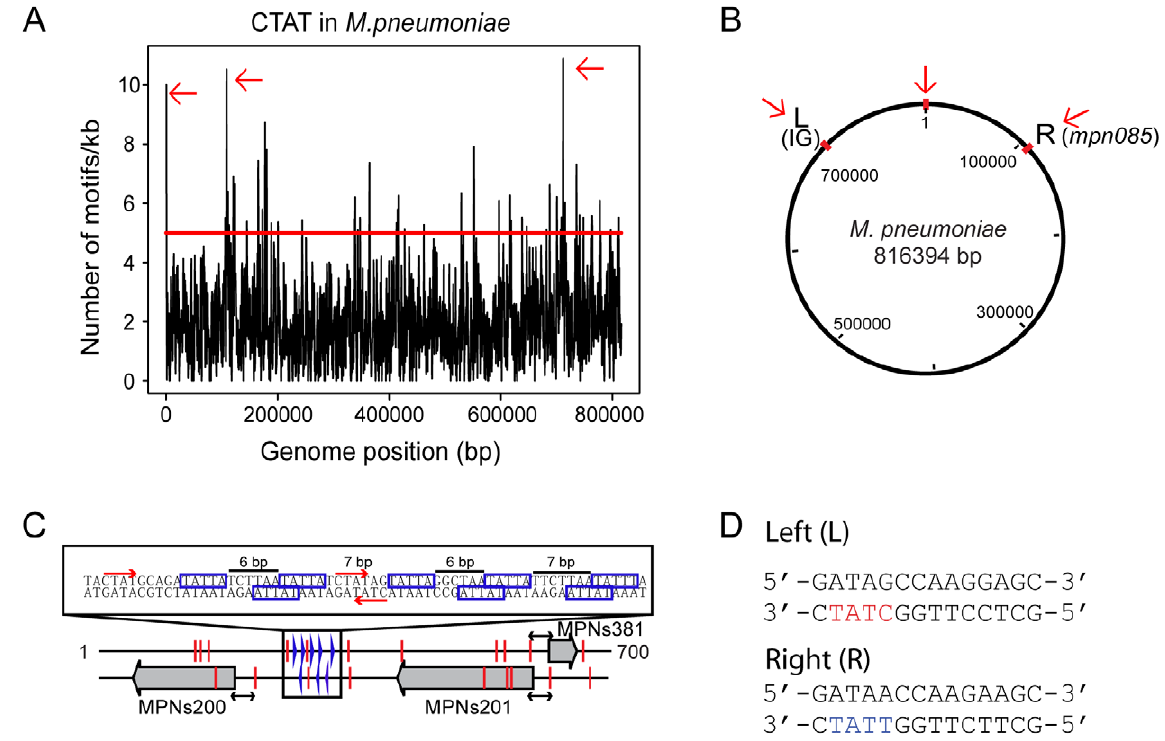
Figure 2. Genome-wide distribution of 5 9 -CT A T-3 9 motif. ( A ) Hot spots of methylation for the 5 9 -CT A T-3 9 motif. The graph represents the number of motifs per 1 kb window. The red line indicates the threshold (5). Regions with more than five 5 9 -CT A T-3 9 motifs are considered ‘‘hot spots of methylation’’. Red arrows indicate the most enriched regions. ( B ) Circular representation of the M. pneumoniae genome. Red marks indicate genome locations of the three main enriched regions of methylation. ( C ) Methylation in the putative origin of replication of M. pneumoniae . Blue boxes indicate putative DnaA boxes. Red arrows and lines indicate methylation sites. Black arrows indicated a common distance (24 bp) from methylation sites to the TSSs of the three MPNs. ( D ) Motif sequences of two putative cell division ‘‘check points’’ (L, left and R, right). Noteworthy only in L motif contains the recognition motif 5 9 -CT A T-3 9 (showed in red letters) on the complementary strand. In contrast, the R motif contains 5 9 -TTAT-3 9 (showed in blue letters) on the complementary strand instead. The three large grey arrows are the three non-coding RNAs (MPNs200, MPNs201 and MPNs381).